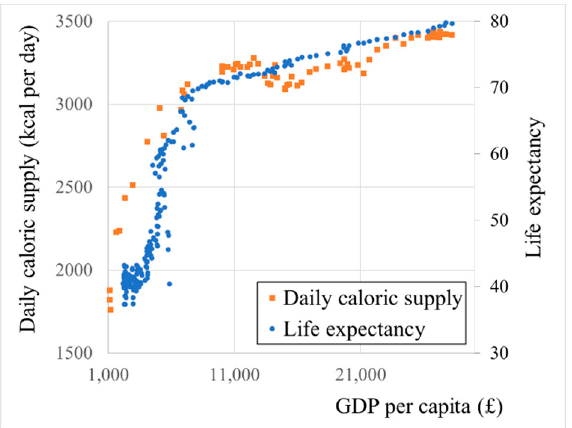
Figure 5. GDP per capita per year related to daily caloric supply and life expectancy; ( a ) United Kingdom’s, GDP, caloric supply data from: 1270–2016 life expectancy data from: 1800–2016 [66,67].